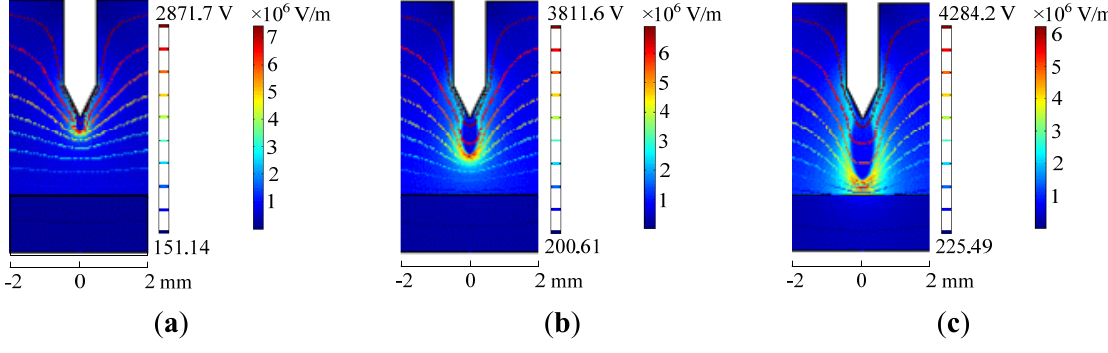
Figure 5. Electric field distribution of a cross section for the SNG: ( a ) 5 ns; ( b ) 7 ns; ( c ) 8.1 ns.